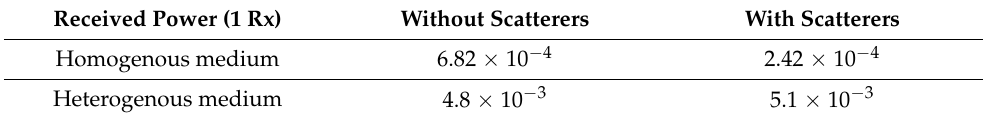
Figure 6. WPT system with single Rx. Table 1. Received power at the Rx port.